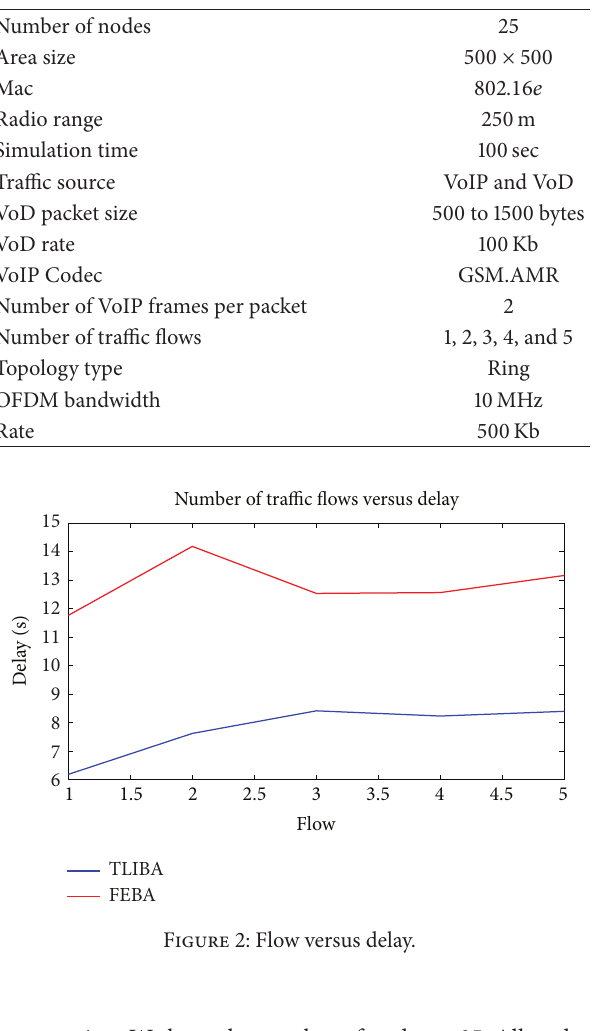
Table 1: Simulation settings.